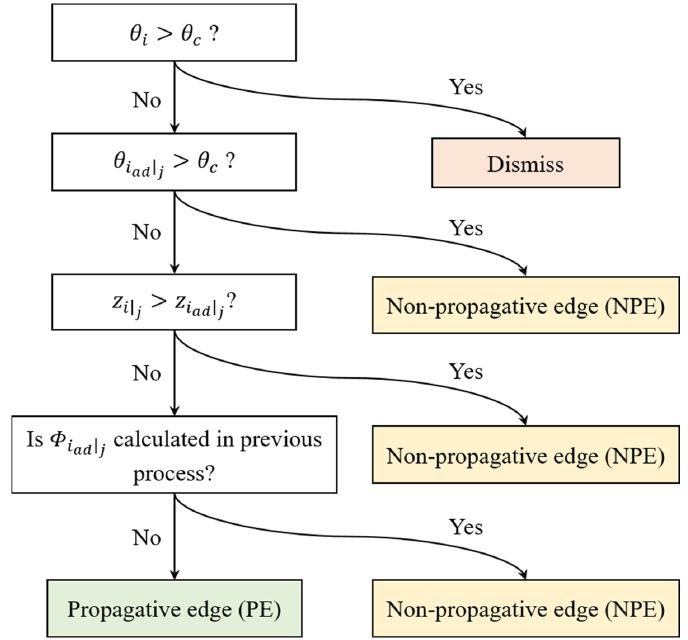
Figure 9. Decision tree for classification of edge j of an origin facet based on attributes of an adjacent facet.